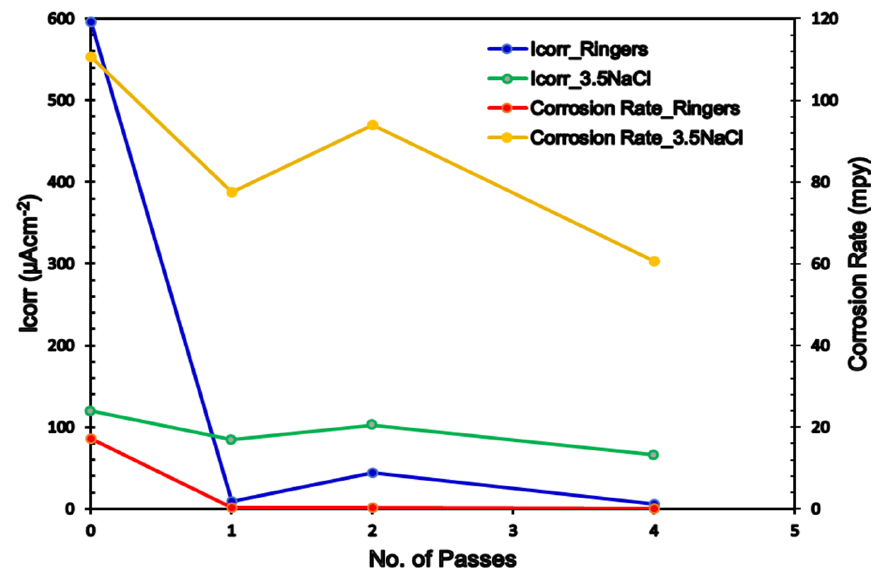
Figure 13. Comparison between the corrosion rate and Icorr for ZK30 in ringer and 3.5% NaCl so- lution